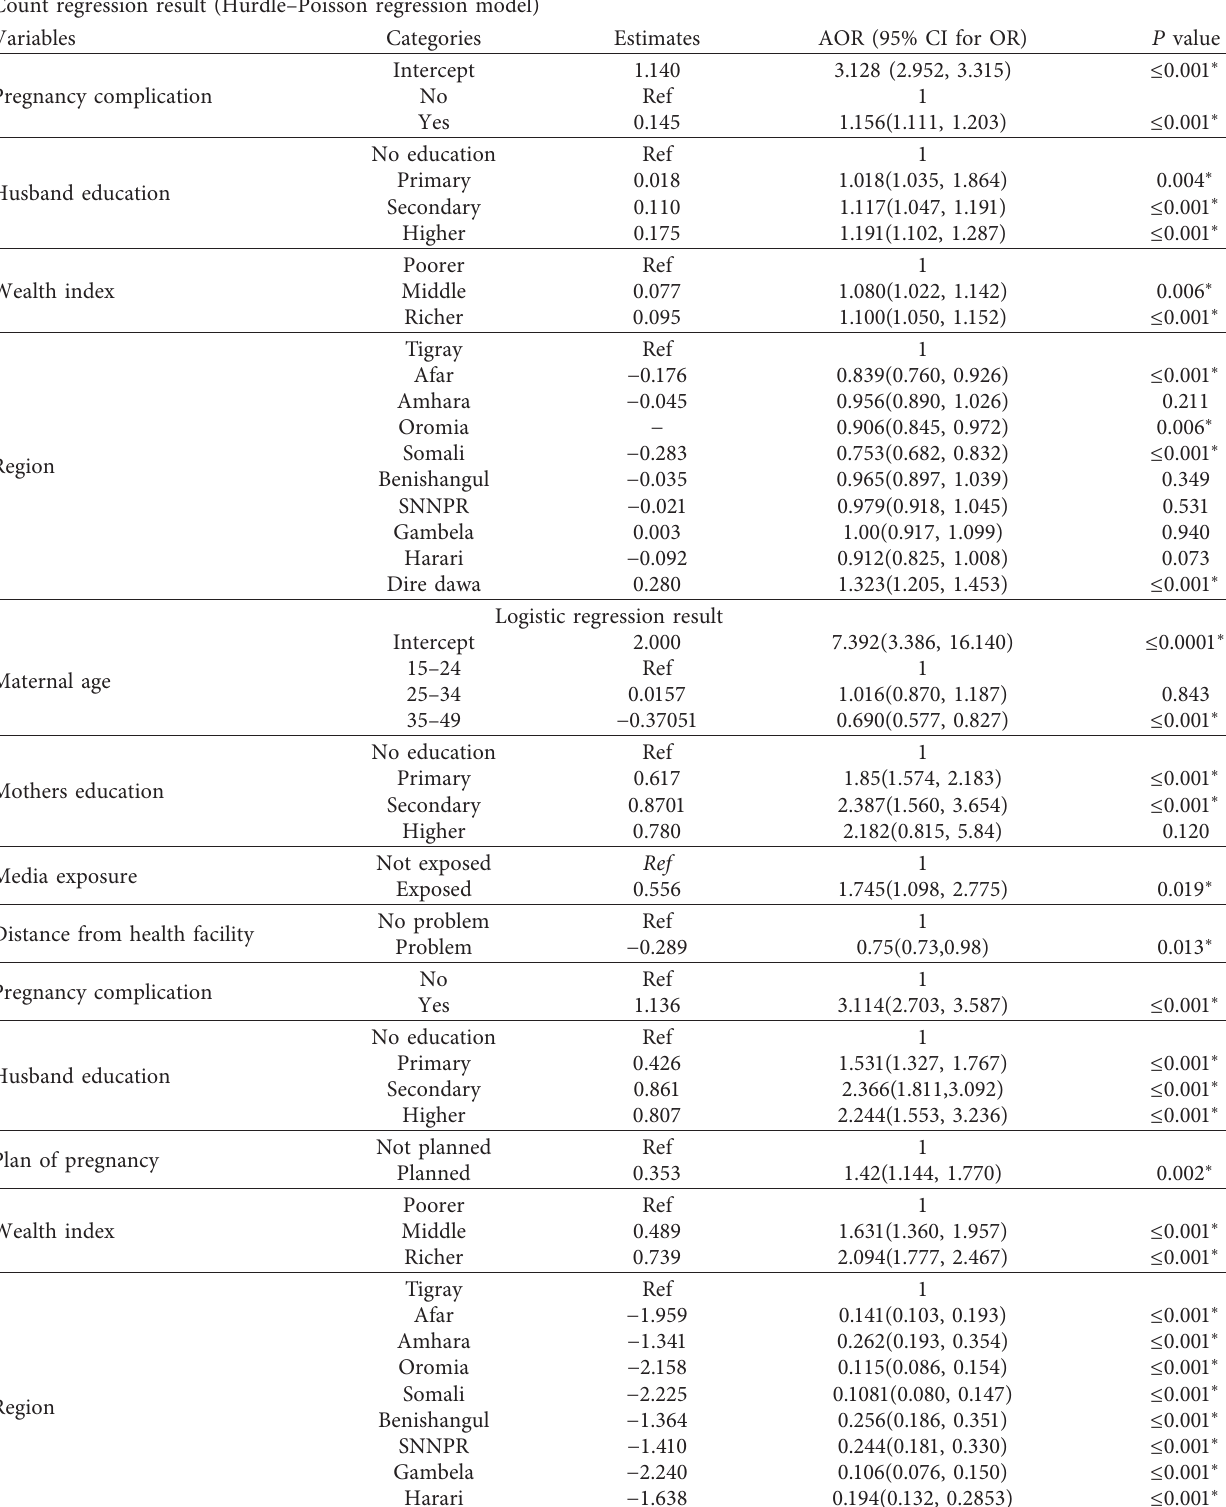
Table 3: Factors associated with the number of ANC service visits ( 0 , 1 , 2 , ... , 8 +) in rural parts of